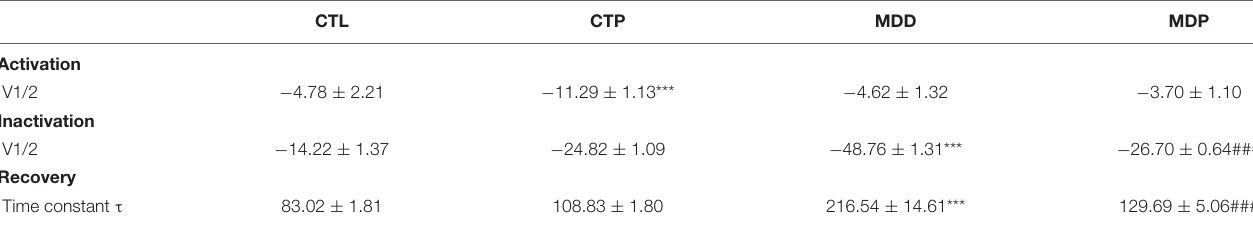
TABLE 1 | Activation, inactivation, and recovery properties of I to .